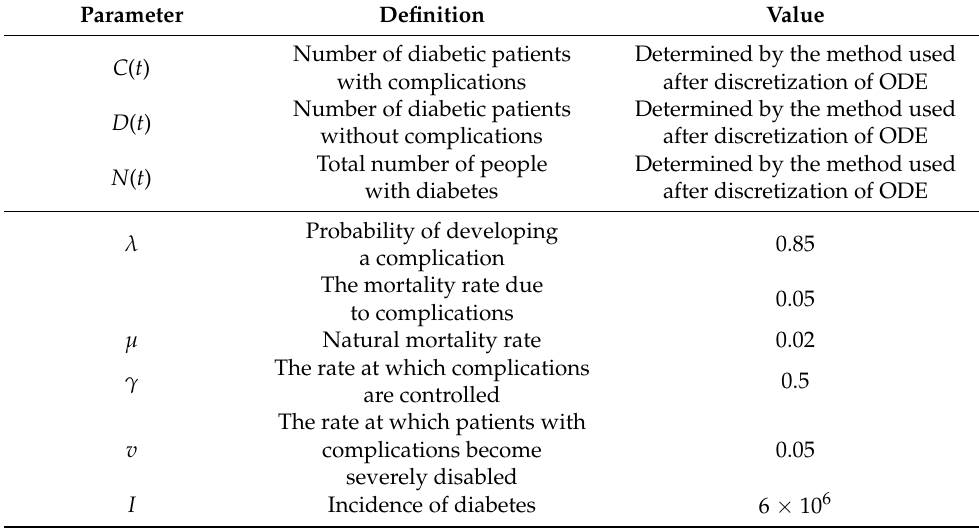
Table 1. Parameter description and values used in discretization of